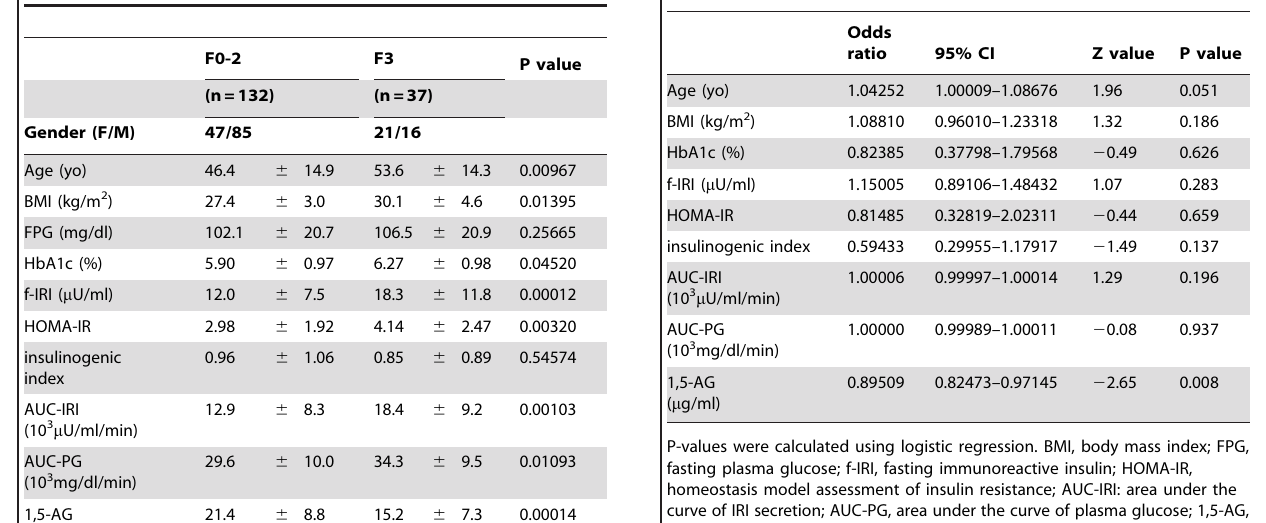
Table 2. Comparison of the parameters of glucose metabolism between patients with mild fibrosis (F0–2) and severe fibrosis (F3).